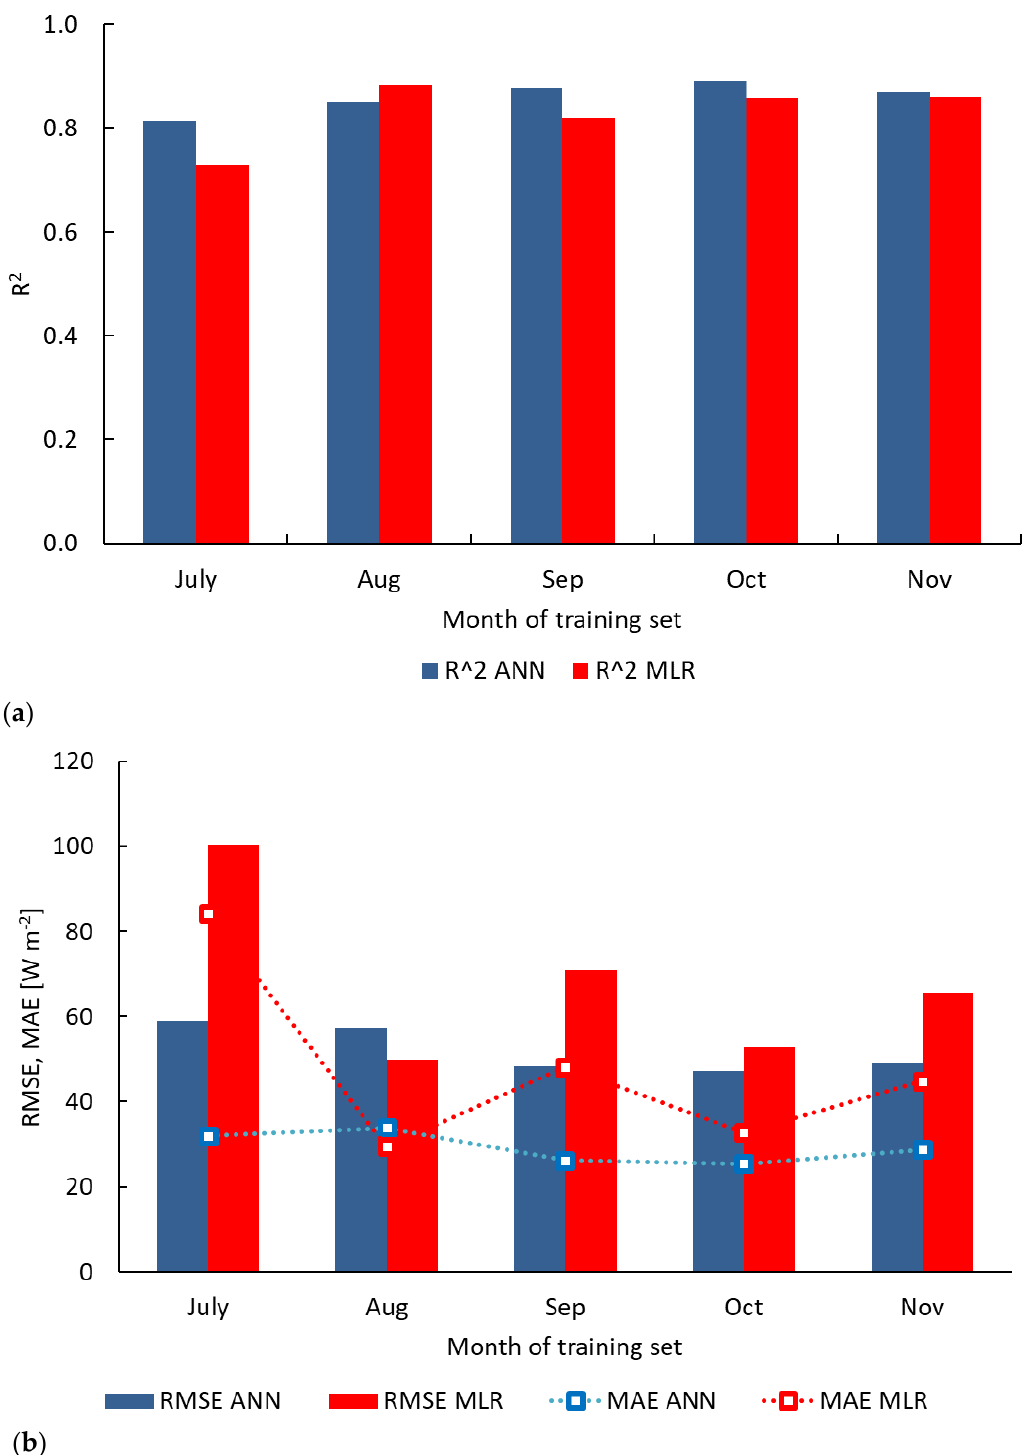
Figure 3. Comparison between R 2 , RMSE and MAE of ANN and MLR models trained using a one-month dataset and validated over the rest of the data during 2017. ( a ) R 2 ; ( b ) RMSE and MAE. Legend: R 2 — bars, RMSE — bars, MAE — square symbols. MLR — red; ANN — blue.